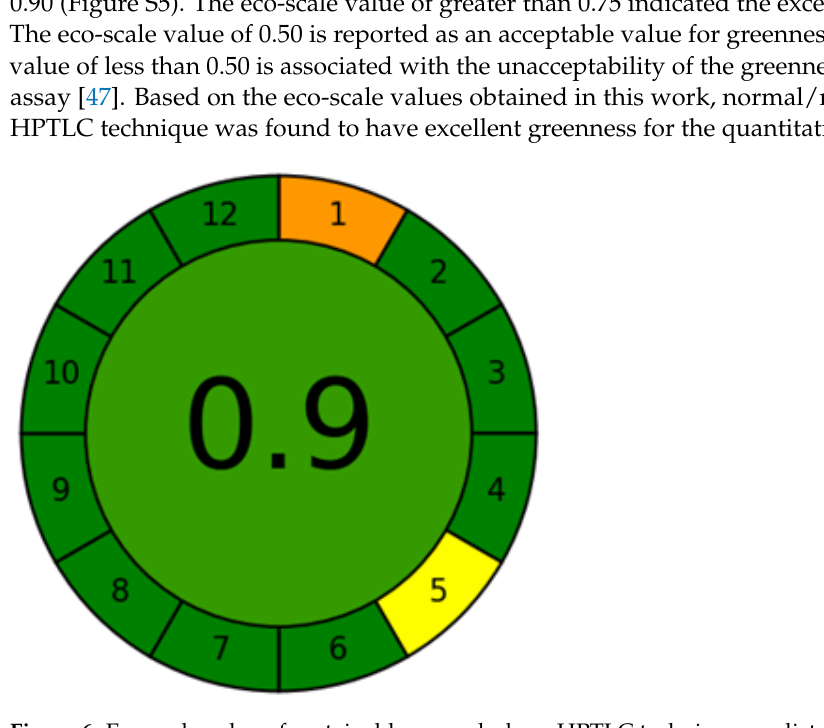
Figure 6. Eco-scale value of sustainable normal-phase HPTLC technique predicted using AGREE: The Analytical Greenness Calculator.